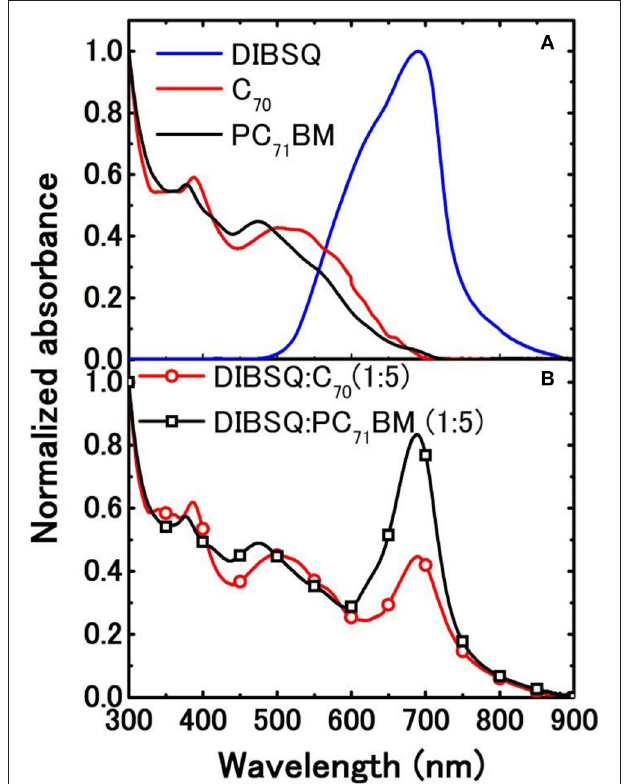
FIGURE 2 | Absorbance of (A) DIBSQ, C 70 and PC 71 BM neat films and (B) DIBSQ:PC 71 BM and DIBSQ:C 70 blend films with blend ratio of